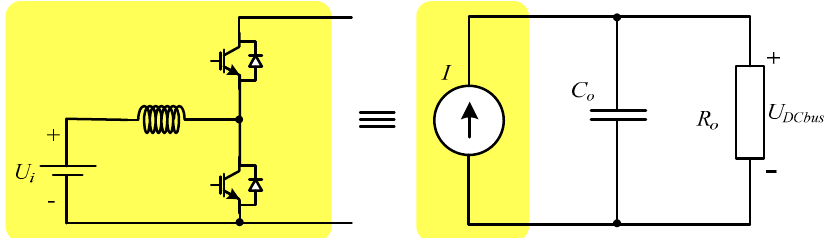
Figure 11. Equivalent circuit of the converter associated to the storage system.